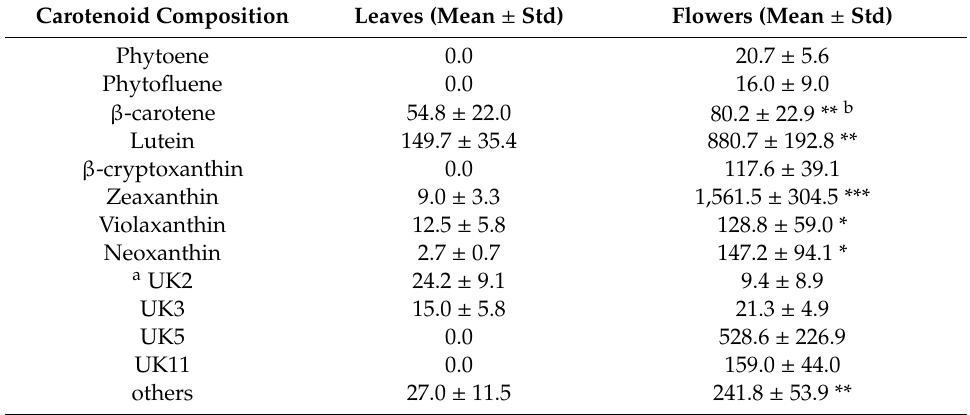
Table 2. Carotenoids contents ( µ g · g − 1 fresh weight (FW)) in the leaves and mature flowers of O. dubium line